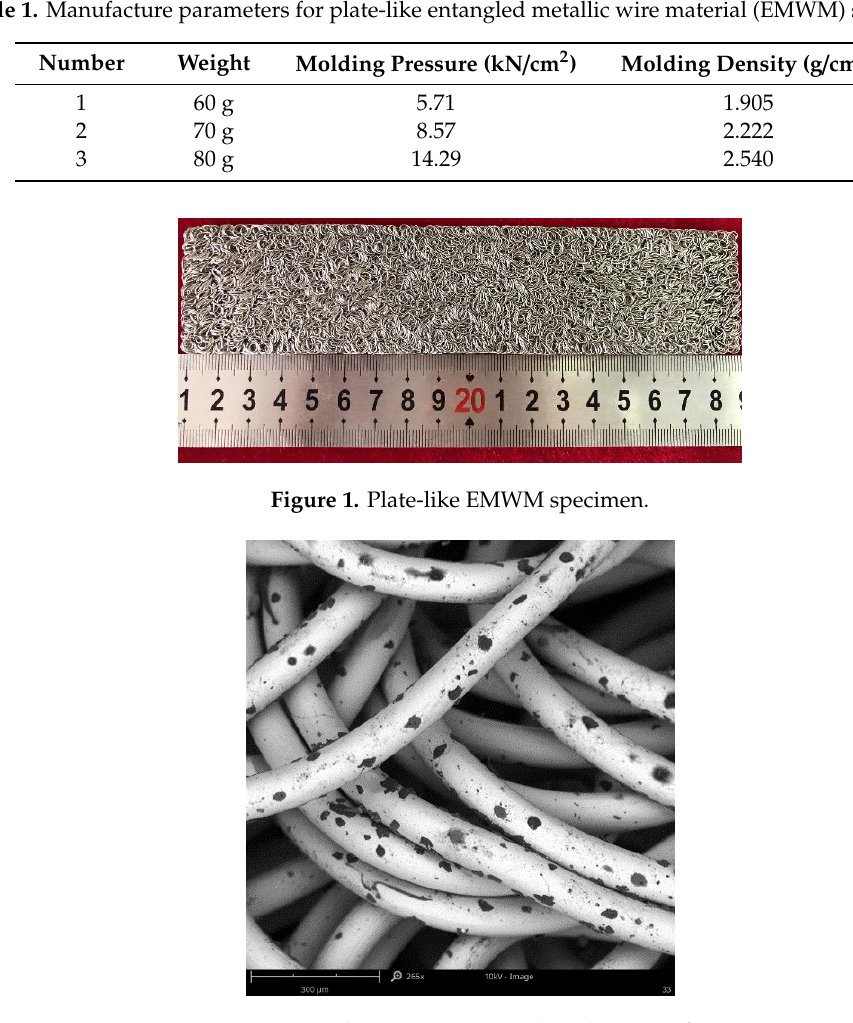
Figure 2. Scanning electron microscope (SEM) image of EMWM.